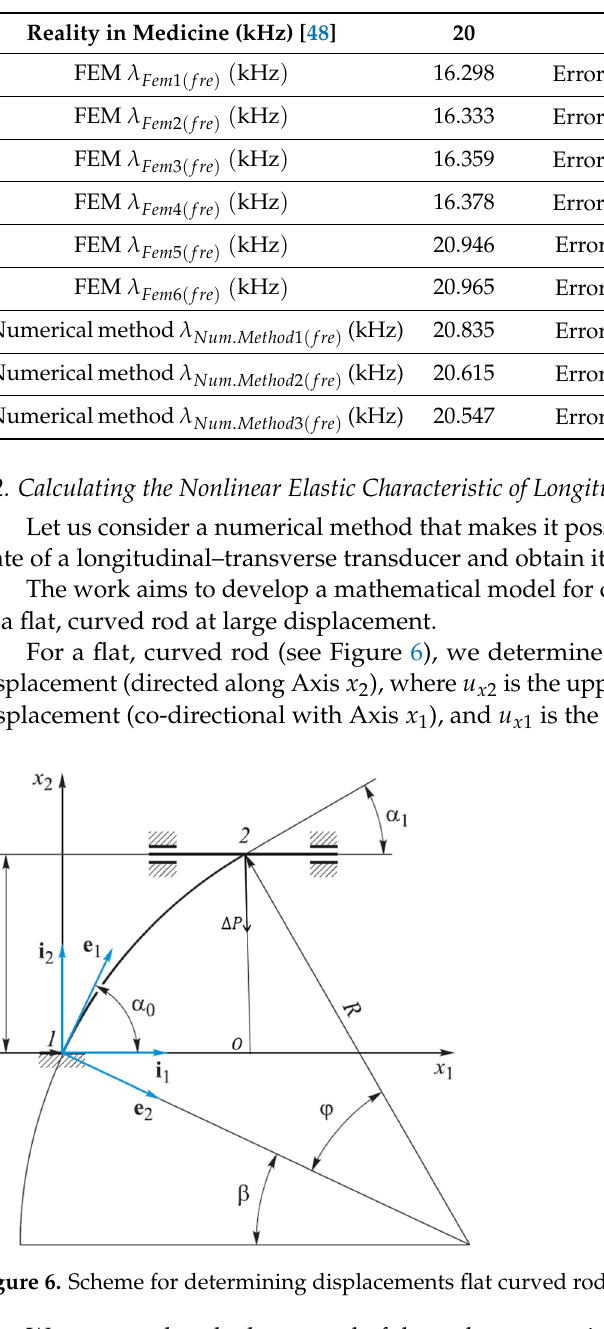
Table 3. Value frequencies of vibrations by FEM and the numerical method, and the reality in medicine.